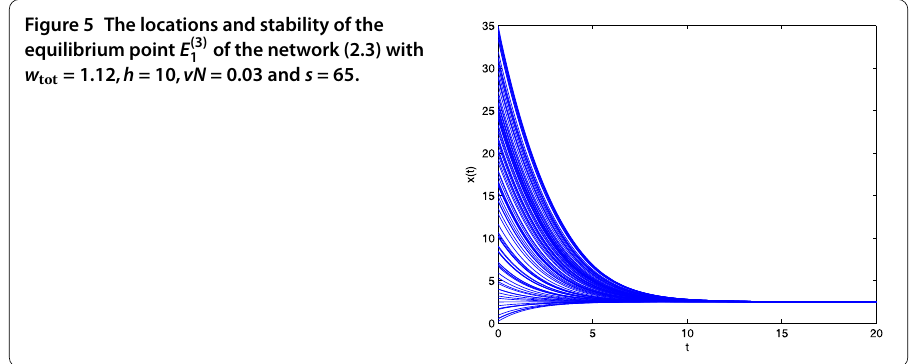
Figure 5 The locations and stability of the equilibrium point E